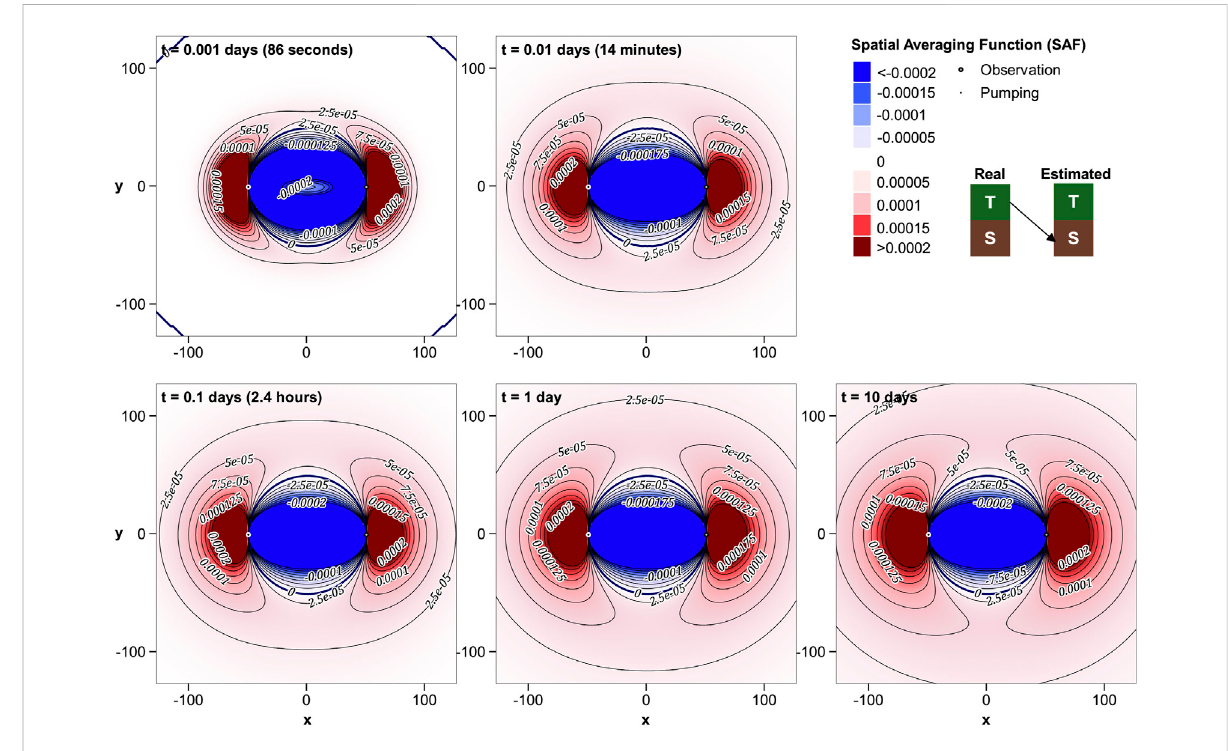
FIGURE 8 R ′ S − T for separated wells at fi ve different